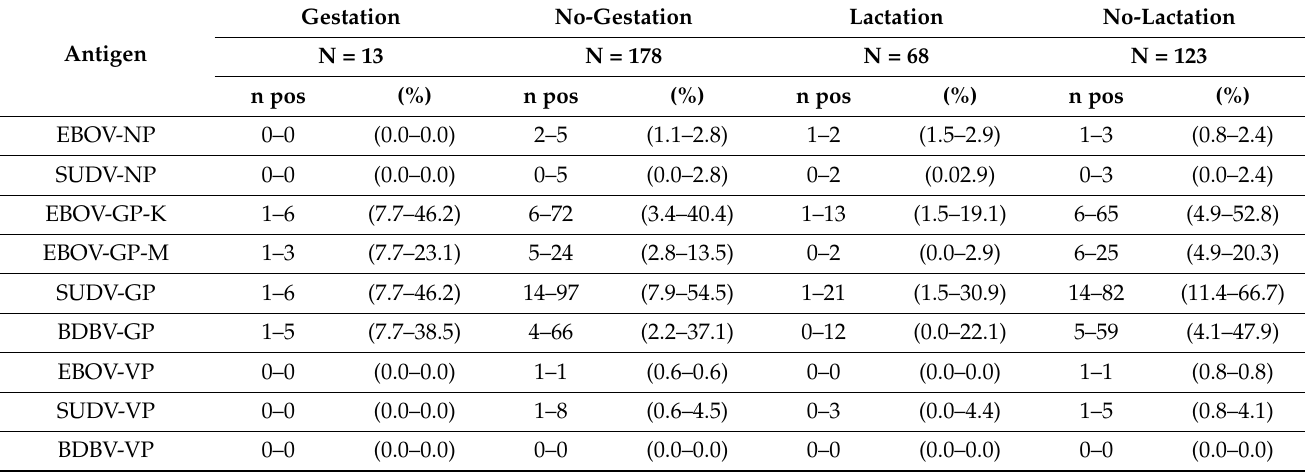
Table 4. Proportion and percentages of samples reactive with the different Ebolavirus antigens according to reproductive stage of adult female Eidolon helvum bats with stringent (statistical methods, see methods) and less- stringent (4 × SD of negative samples) cut-off values. The assay used recombinant proteins of Nucleoprotein (NP), Viral Protein-40 (VP40) or Glycoprotein (GP) for